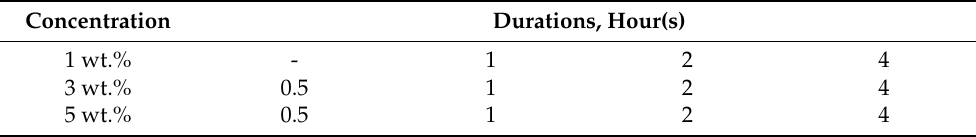
Table 2. Concentration of NaOH solution and duration of treatments